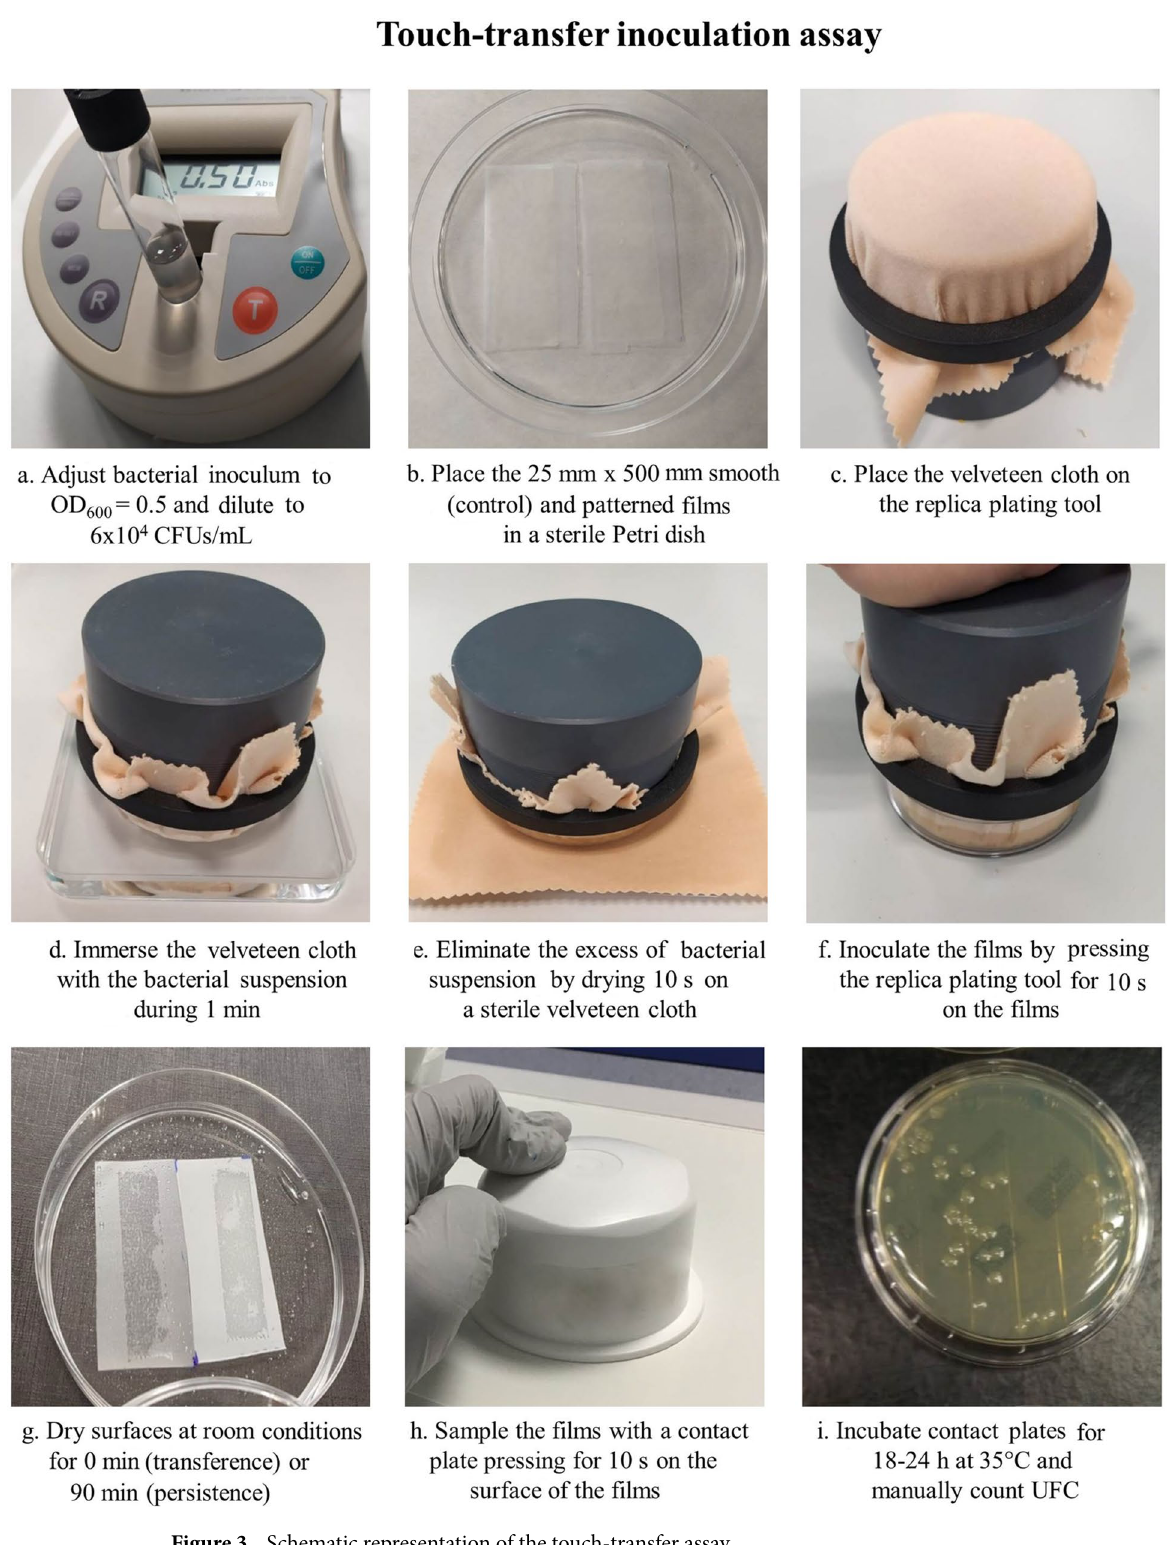
Figure 3. Schematic representation of the touch-transfer